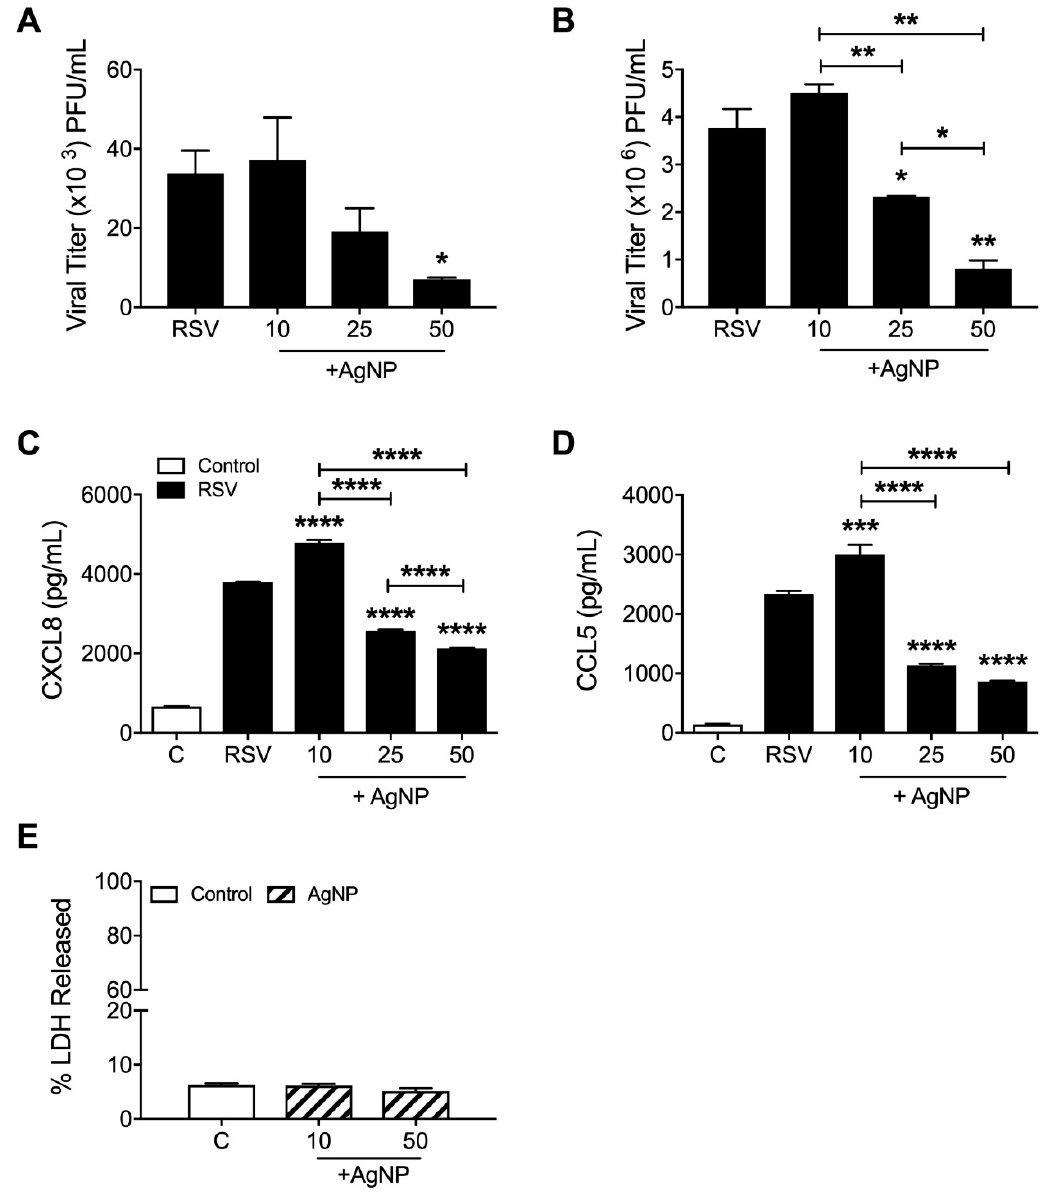
Figure 1. Silver nanoparticles (AgNPs) decreased respiratory syncytial virus (RSV) replication in epithelial cell lines. ( A ) A549 cells were infected with RSV or AgNP-RSV (0, 10, 25, or 50 μ g/mL) at a multiplicity of infection (MOI) of 1 and ( B ) HEp-2 cells were infected with RSV or AgNP-RSV at an MOI of 0.01. Supernatants of infected cells were collected as described in the methods. Viral replication was determined by plaque assay and ( C ) CXCL8 and ( D ) CCL5 levels were determined by enzyme-linked immunosorbent assay (ELISA). ( E ) The toxicity of AgNPs (0, 10, and 50 μ g/mL) on A549 cells was determined using LDH as an index of cellular damage. Data are expressed as mean ± SEM and is representative of three independent experiments. Significant results as compared to the RSV control are marked with asterisks, and additional comparisons between groups are indicated with brackets (* for p ≤ 0.05, ** for p ≤ 0.01, *** for p ≤ 0.001, **** for p ≤ 0.0001).